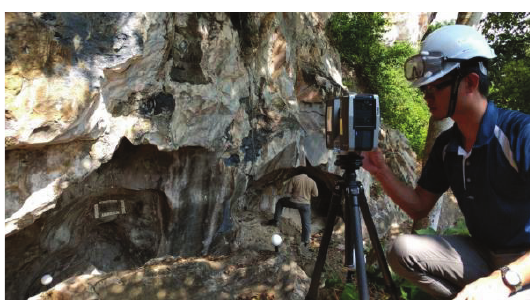
Figure 9: The setup of the laser scanner and the positions of the sphere targets for the acquisition of the paintings data Figure 10 shows the plan view of the terrestrial laser scanning data. The figure also visualized the position of the scanning stations and the sphere targets.